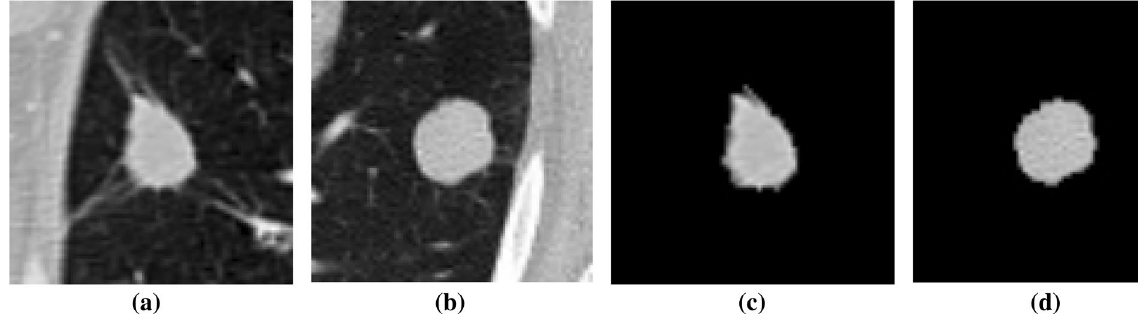
Figure 1. Preprocessing process of positive samples.